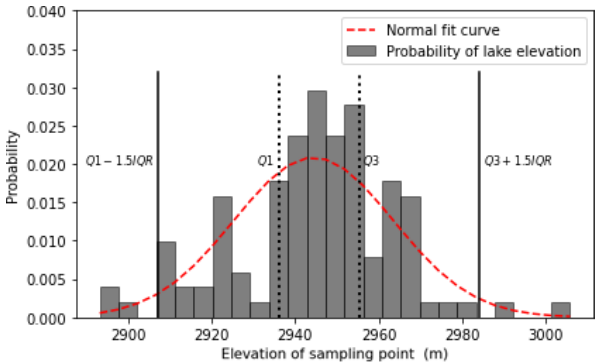
Figure 7. Elevation distribution for the sampling points used in the case of the Baige landslide